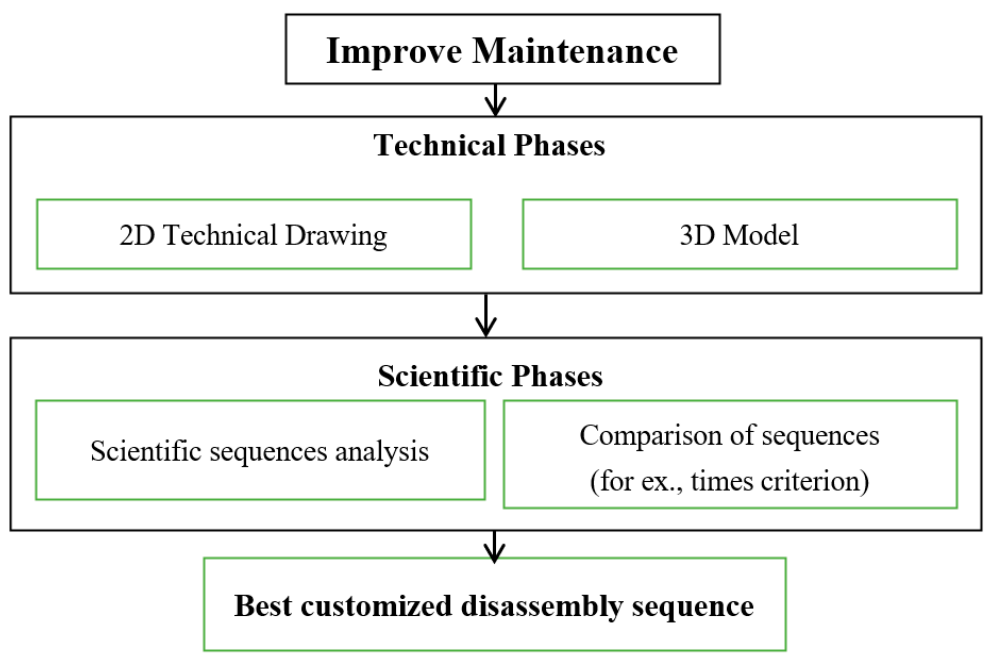
Figure 5. Disassembly process developed.